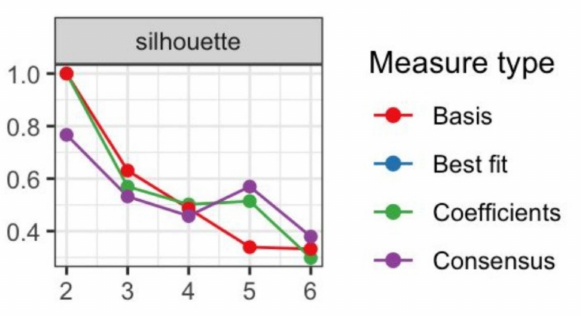
Figure A1. Estimation of the best K cluster using the silhouette method.